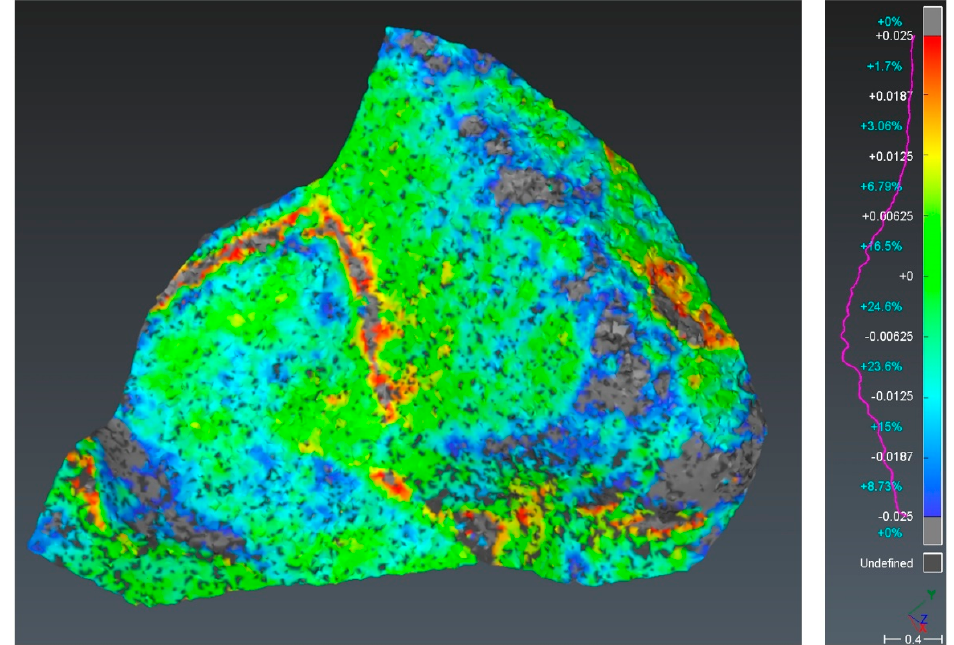
Figure 16. Height comparison of TLS and UAS clouds on the boulder area and the histogram in the range up to 25 mm.